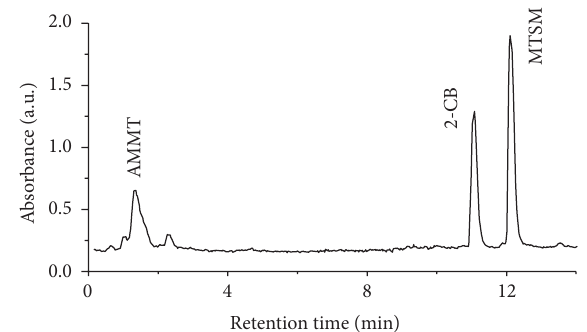
Figure 5: HPLC chromatogram of a solution obtained by extraction withmethanolofanirradiatedmixtureMTSM/Kaolinite[MTSM] = 5.2 𝜇 mol g −1 . Detection at 𝜆 max = 250 nm using a gradient program (see Section 2). Irradiation was performed in a Sunlight simulator.